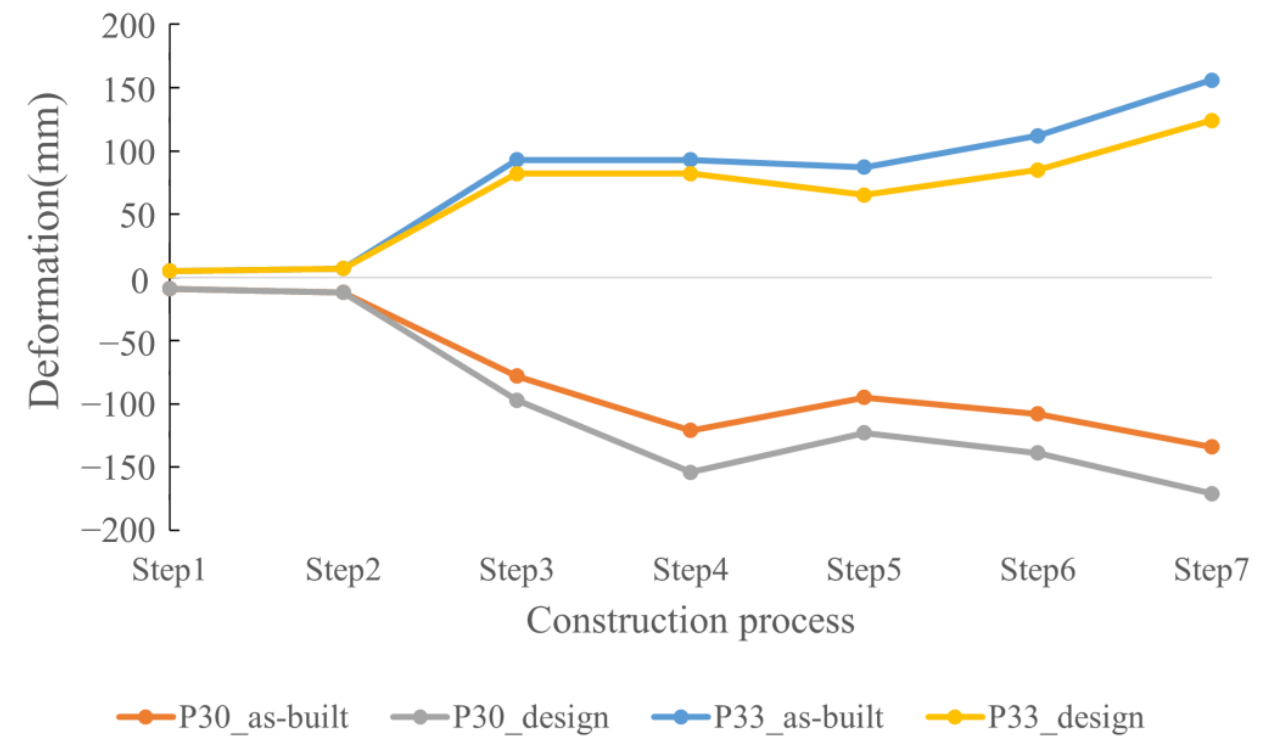
Figure 13. Pier inclination in the design model and as-built model.